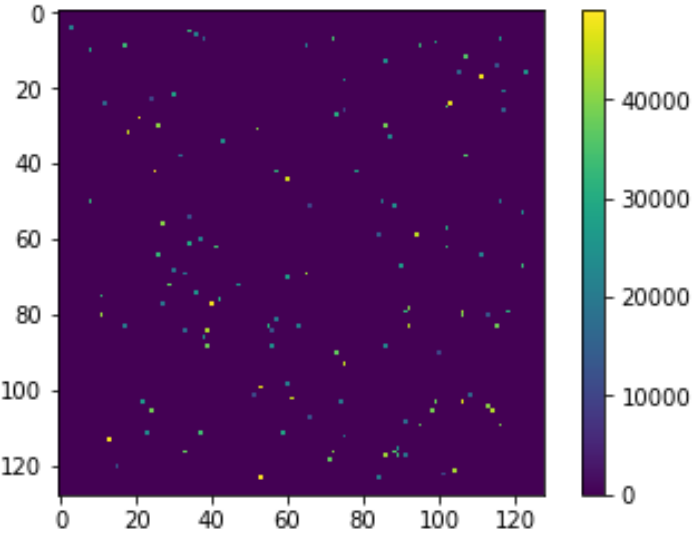
Figure 2. Sample reference